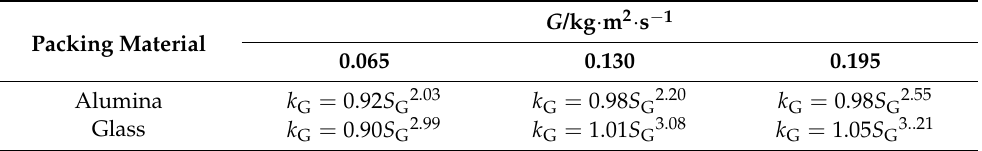
Table 2. Correlations of the gas phase relative permeability vs. the gas phase saturation in the liquid flow rate’s decreasing